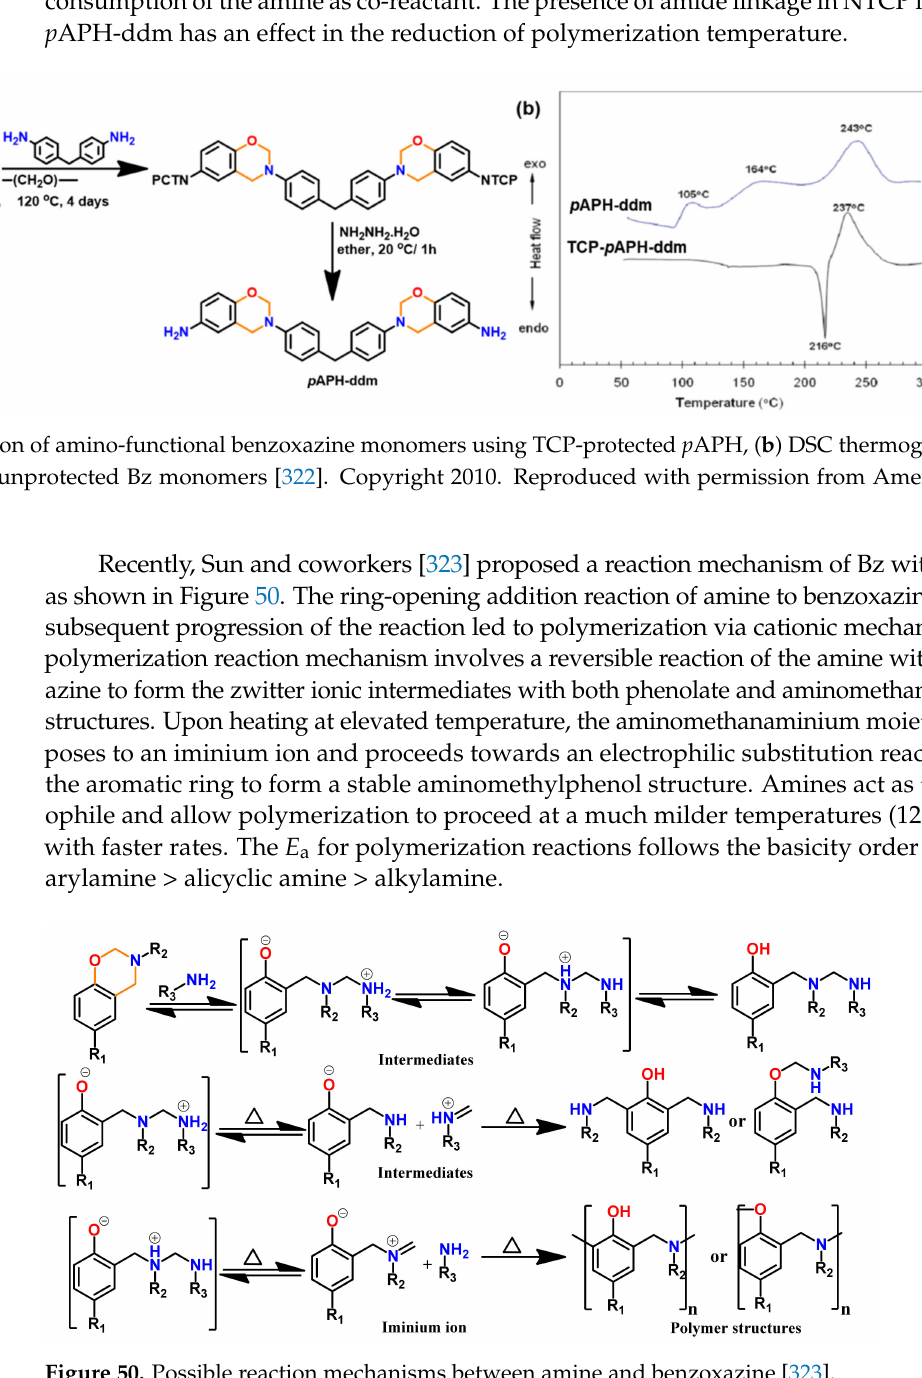
Figure 50. Possible reaction mechanisms between amine and benzoxazine